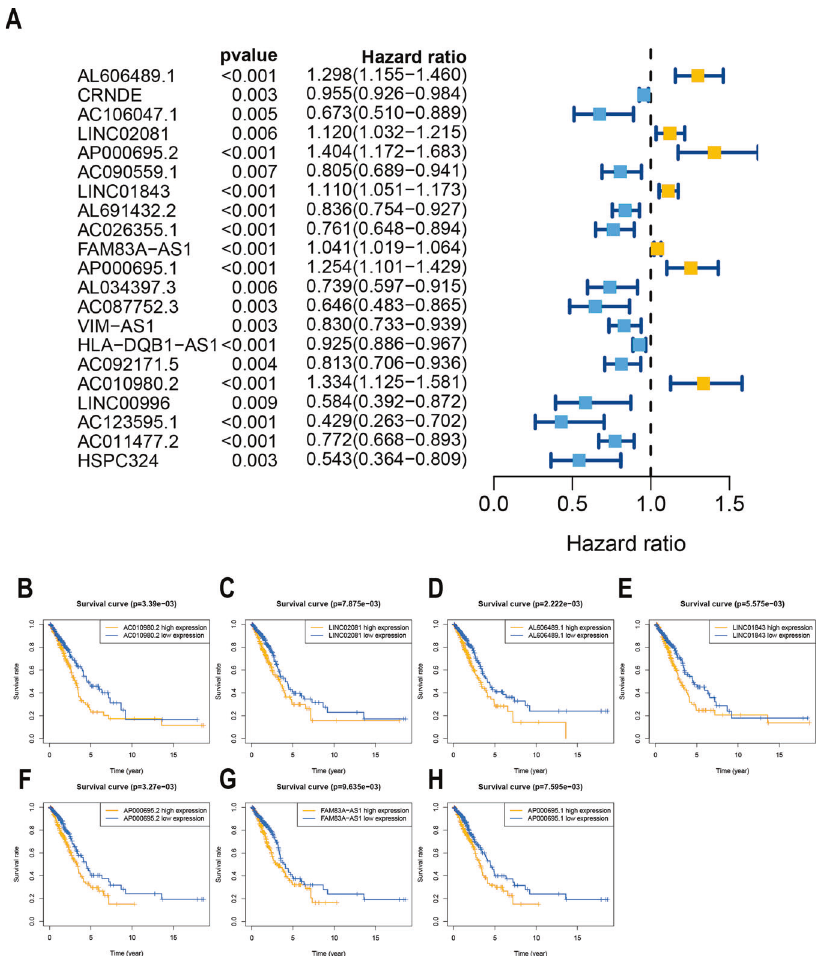
Fig. 1 Identi fi cation of ferroptosis-related lncRNAs with signi fi cant prognostic value in LUAD. A Forest plot showing the HR (95% CI) and P values for selected lncRNAs determined using univariate Cox proportional hazards analysis (all P < 0.01). Fourteen lncRNAs were associated with a good prognosis, and 7 lncRNAs were associated with a poor prognosis. Kaplan – Meier survival curves for seven unfavorable prognostic ferroptosis-related lncRNA markers: ( B ) AC010980.2, ( C ) LINC02081, ( D ) AL606489.1, ( E ) LINC01843, ( F ) AP000695.2, ( G ) FAM83A-AS1, and ( H ) AP000695.1 ( P <